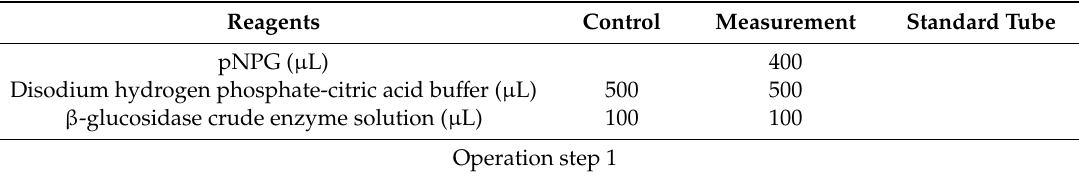
Table 1. The calibration curve for p-nitrophenol was y = 0.007x + 0.003, R 2 = 0.9986. Table 1. Measurement of the β -glucosidase